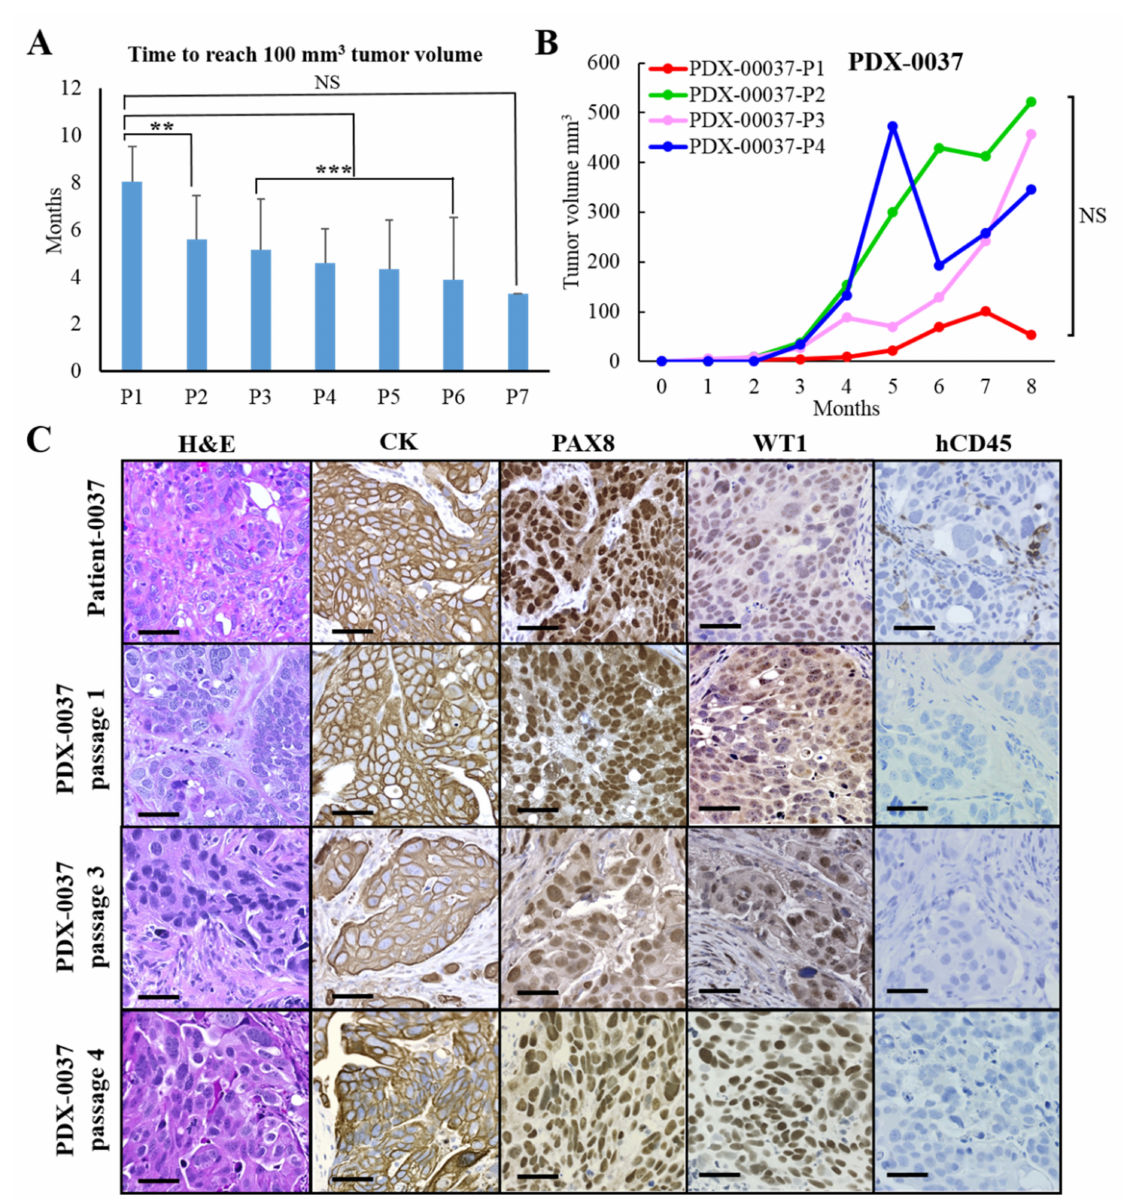
Figure 2. Analysis of tumor growth rates and IHC characterization of PDXs. ( A ) Analysis of tumor growth rates of 17 PDX models. Graph represents an average latency time of each PDX passage to develop a tumor (~100 mm 3 volume) from the time of implantation. Data are represented as mean ± SEM, illustrating differences between latency time of P1 vs. other passages (one-way ANOVA followed by Tukey’s multiple comparisons test, ** = p < 0.01, *** = p < 0.001). ( B ) Graph shows growth rates of individual passages of a representative PDX model (one-way ANOVA followed by Tukey’s multiple comparisons test, NS = not significant). ( C ) PDX tumor sections were H&E stained and evaluated by IHC for HGSOC subtype markers (CK, PAX8 and WT1) and the presence of human immune cells (hCD45). Scale bars: 50 µ m. For additional information, see Supplementary Figures S2 and